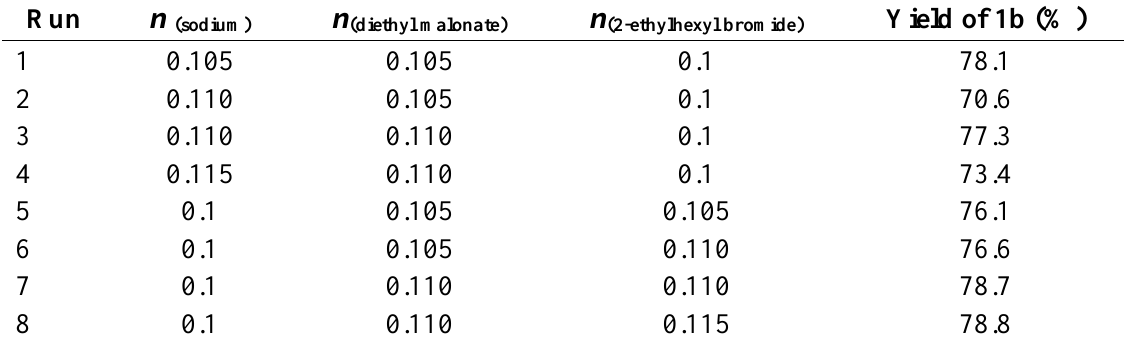
Table 1. Influence of different mole ratio of materials on the